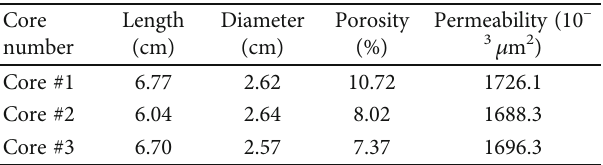
Table 1: Summary of physical properties of the cores applied in this